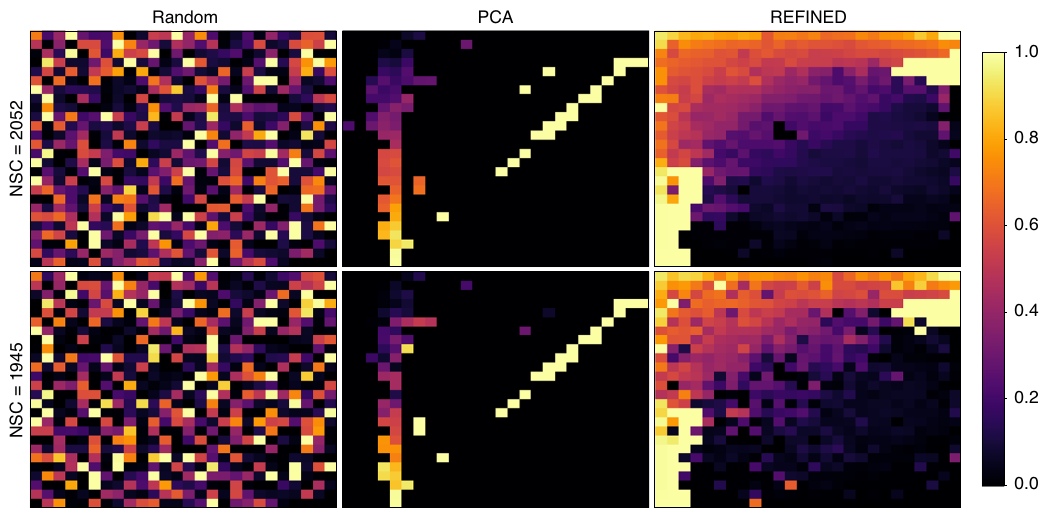
Fig. 1 Examples of image generation through different approaches. Illustration of some example images for NCI60 drug descriptors, where each title denotes the associated image generation method, and each drug is denoted by a unique NSC ID 54 assigned by the Development Therapeutic Program (DTP) of National Cancer Institute (NCI) to a chemical agent or product ranging from small molecules to compounds.